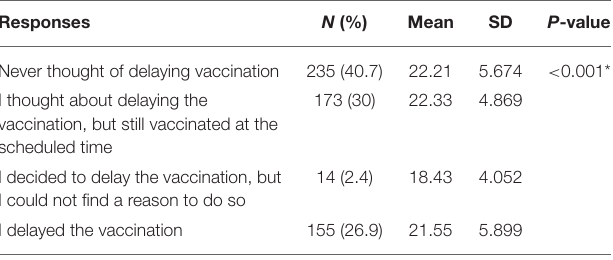
TABLE 3 | Fear level of COVID-19 stratified by the decision about vaccination ( N = 577). Responses